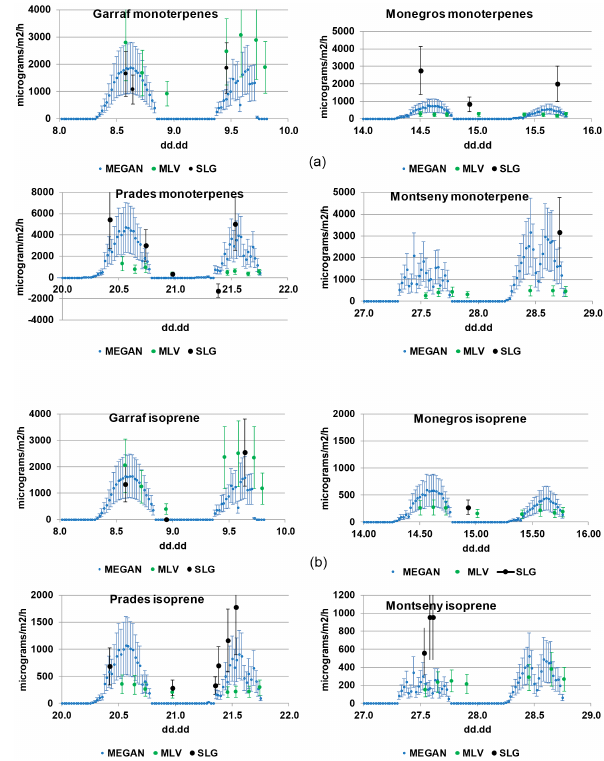
Figure 3. Comparison of the estimates of the MEGAN model with the surface layer gradient and the mixed layer variance techniques for the fluxes of (a) monoterpenes and (b)